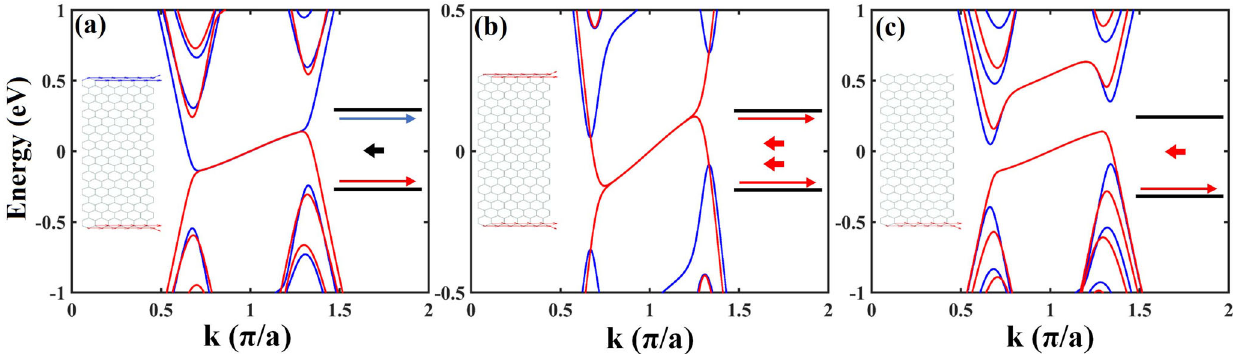
Fig. 7 The band structure of one case of Type-3, Type-4 and Type-5. a Type-3 with M 1 = 0.2 t , M 2 = 0.2 t , and E Z = 0.2 t ; b Type-4 with U 1 = 0.1 t , U = − 0.1 t , M = − 0.1 t , and M = 0.1 t ; c Type-4 with U = 0.2 t , M = 0.2 t , and E = 0.2 t . Inset: local bond current distribution ( E = 0.03 eV) and schematic 2 1 2 1 2 Z diagram of corresponding edge states. The black arrow denotes the spin degeneracy case, and the red (blue) bands or arrows denote the spin-up (down) case. Other fi xed parameters are the same as in Fig.